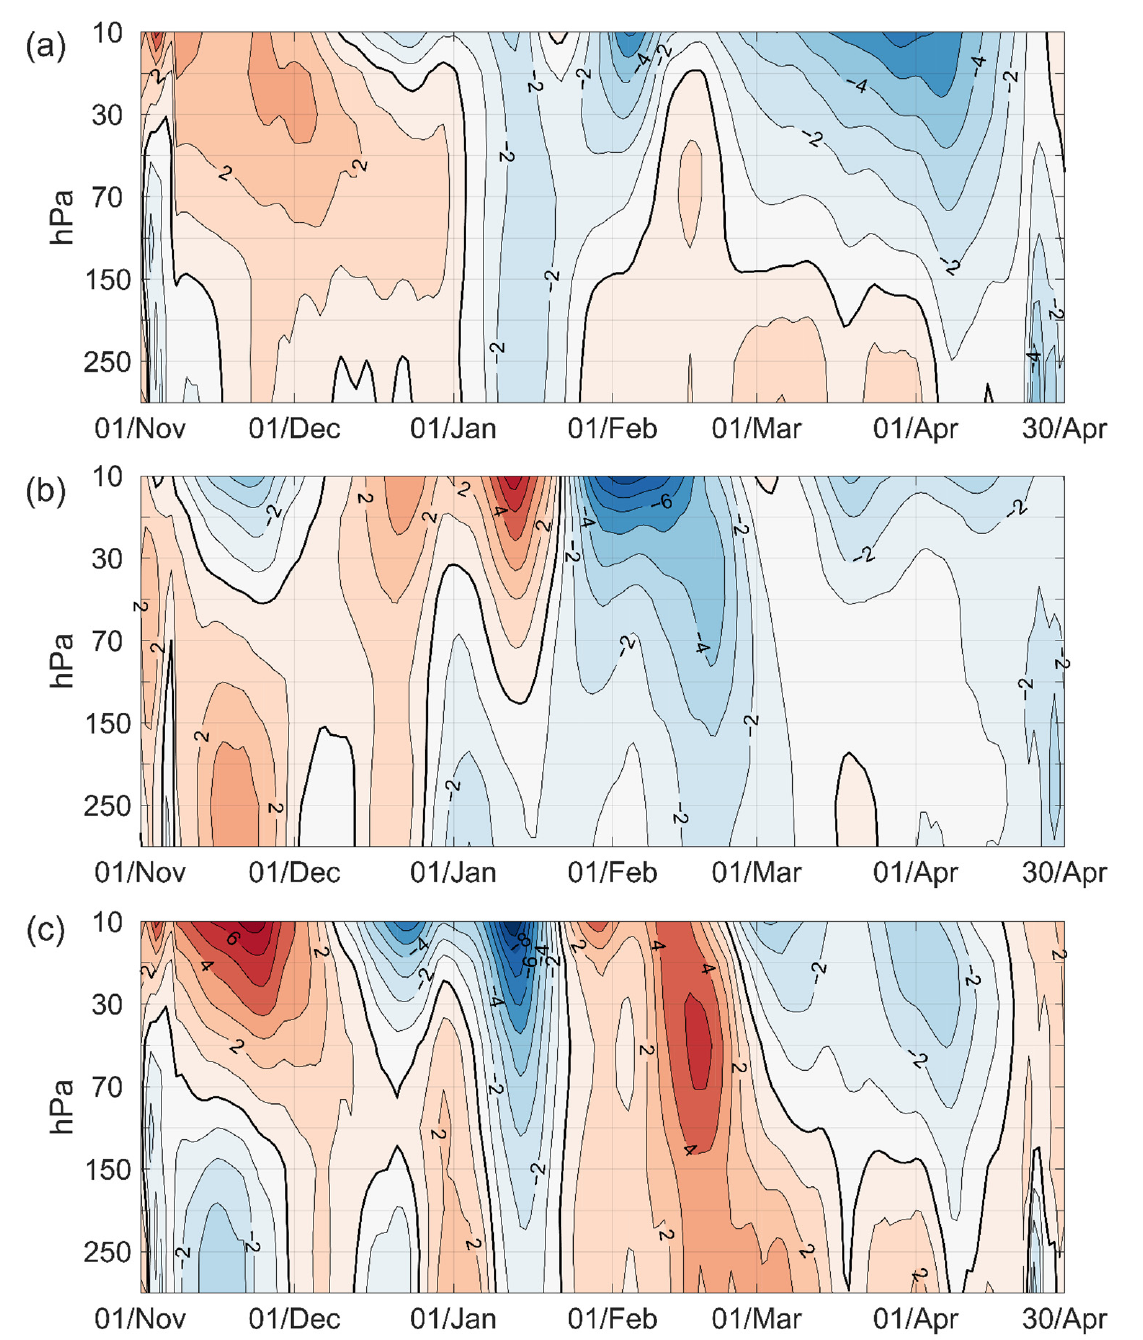
Figure 7. Composite vertical sections of daily anomalies in zonal mean wind at 60° N for ( a ) Eastern Pacific and ( b ) Central Pacific El Niño events and ( c ) difference between composites of EP and CP El Niño events. Values are smoothed with a 15-day running mean. Contour interval is 1 m/s. Black bold line indicates zero isoline.